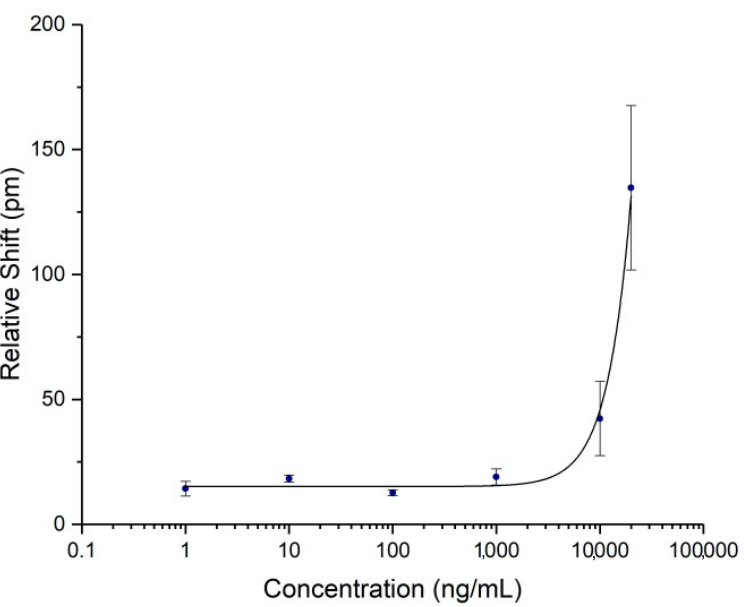
Figure 3. Spike Protein Calibration Curve. Recombinant spike protein S1+S2 ECD was diluted in AWB with 20% FBS to a known concentration and flowed over a chip functionalized with anti-spike antibody. Three assays were run at each concentration. Error bars represent the standard error for each concentration.